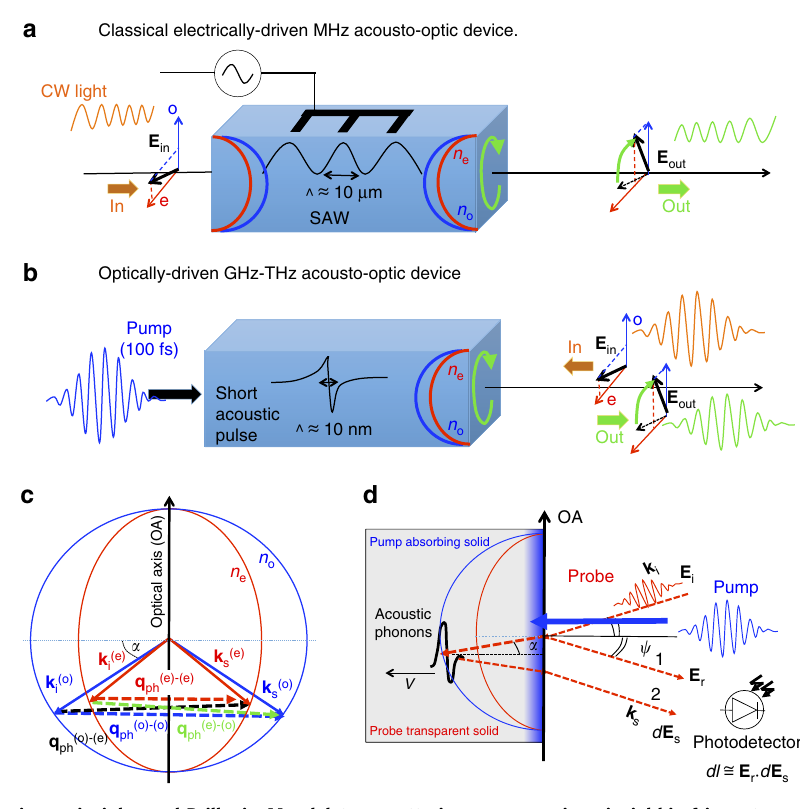
Figure 1 | Acousto-optic devices principles and Brillouin–Mandelstam scattering processes in uniaxial birefringent crystal. Principle of acousto-optic devices: ( a ) current electrically driven MHz collinear acousto-optic devices based on the modulation of continuous waves (cw) light polarization (light electric field E in converted into E out ) assisted by acoustic waves (example of SAW generated by piezoelectric materials usually 10 ). The symbols (e) and (o) mean extraordinary and ordinary light components. ( b ) Proposed concept of light-driven GHz–THz acousto-optic devices based on high-frequency coherent acoustic phonons (generated with femtosecond laser pulses). In this latter scheme, a light mode conversion (light electric field E in to E out ) is induced by a very localized acoustic strain gradient (10nm) preliminary photoinduced by a femtosecond laser. The acousto-optic interaction results in the backscattering geometry to a time-dependent modulation of the Brillouin light intensity controlled by the moving acoustic front (ps time-scale modulation). The intensity and polarization of the scattered light can be tailored by engineering the spectrum of the incident picosecond acoustic pulse. ( c ) Four possible